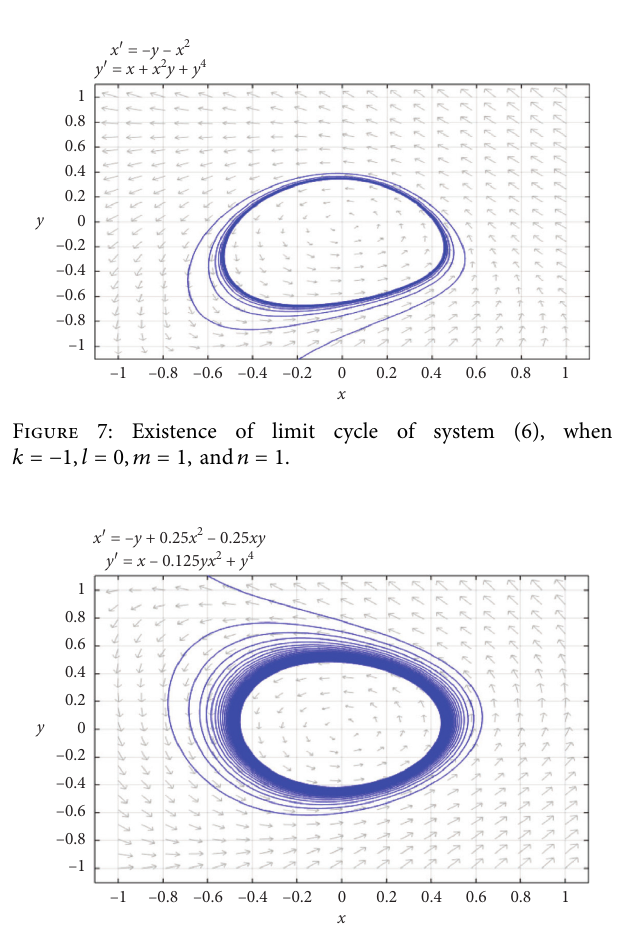
Figure 8: Existence of limit cycle of system (6), when k � 0 . 25 ,l � − 0 . 25 , m � − 0 . 125 , and n � 1.